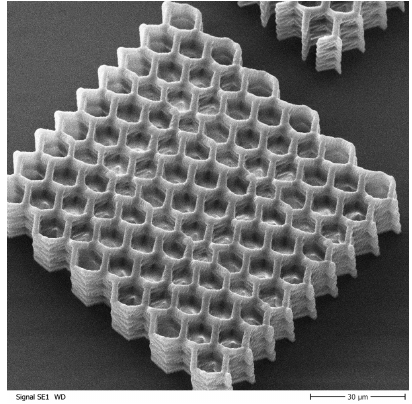
Figure 21. Dimension scale: hex structure (30 mi- crons x 34.64 microns side length per